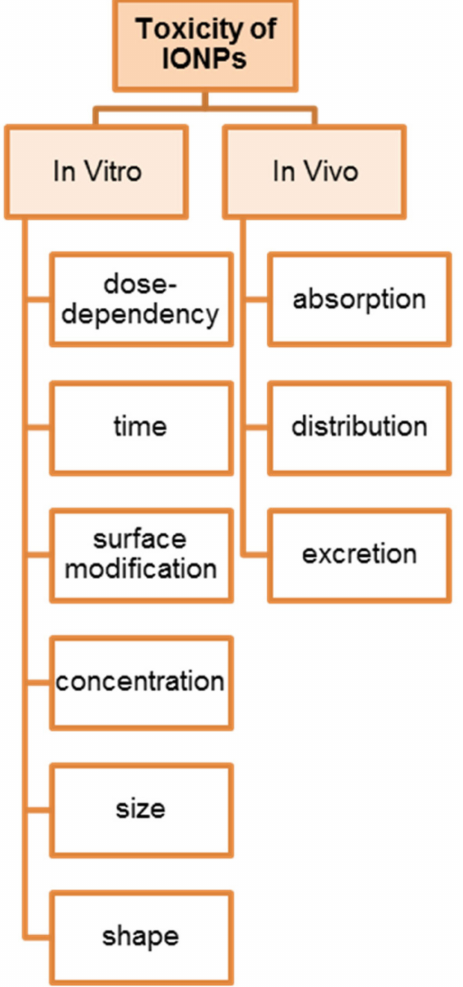
Figure 2. Criteria for evaluation of toxicity of